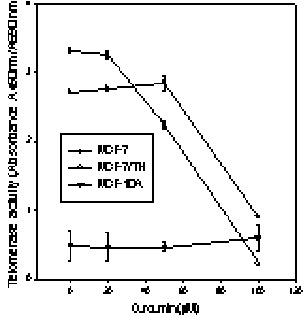
Fig. 3. Inhibition of telomerase activity by curcumin.